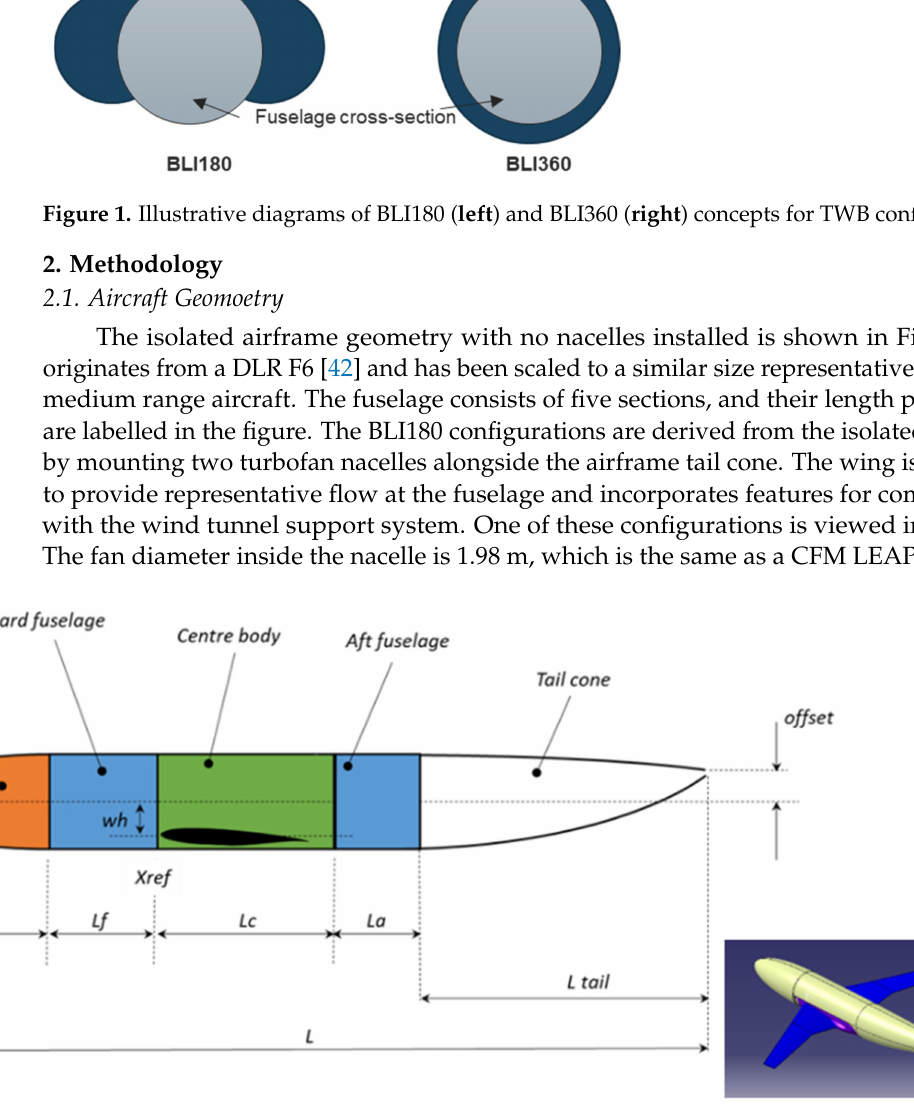
Figure 2. Isolated airframe geometry designed based on DLR F6 [42].